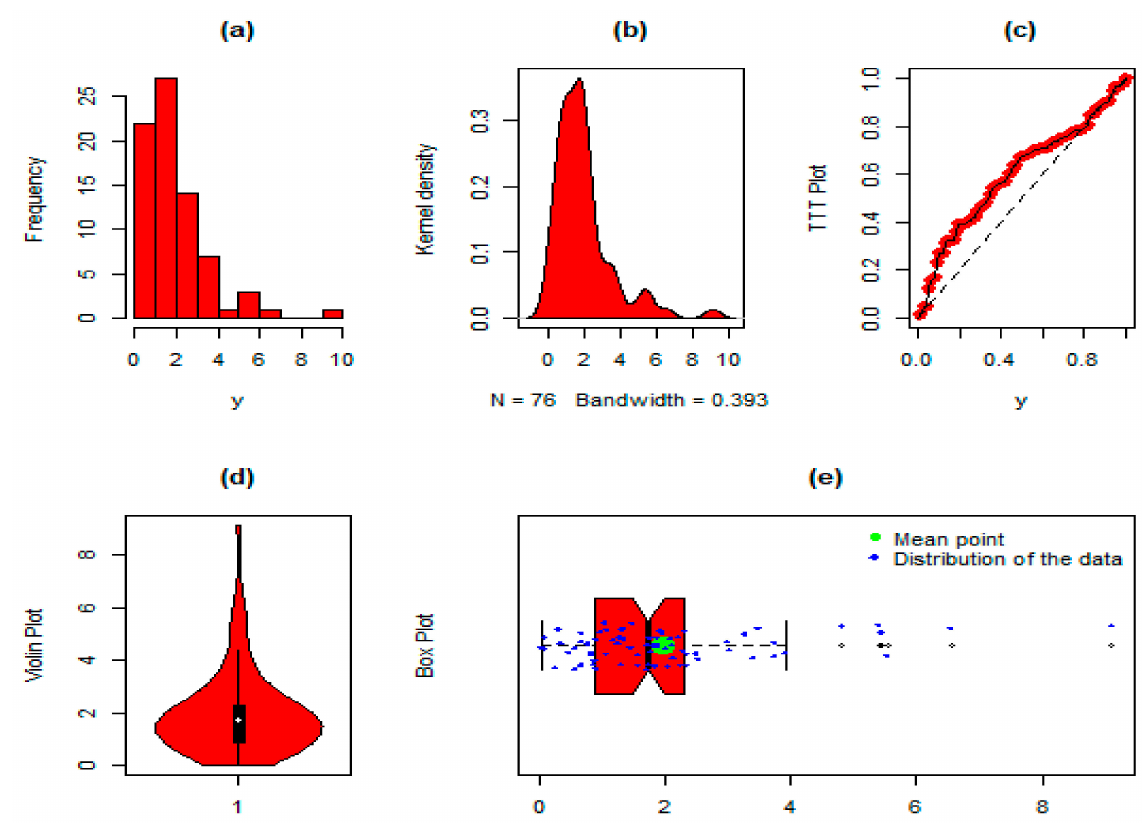
Figure 15. The ( a ) Histogram, ( b ) Kernel density plot, ( c ) TTT plot, ( d ) Violin plot, and ( e ) box plot for Data 2. Table 6. The values of using fatigue fracture data set (Data